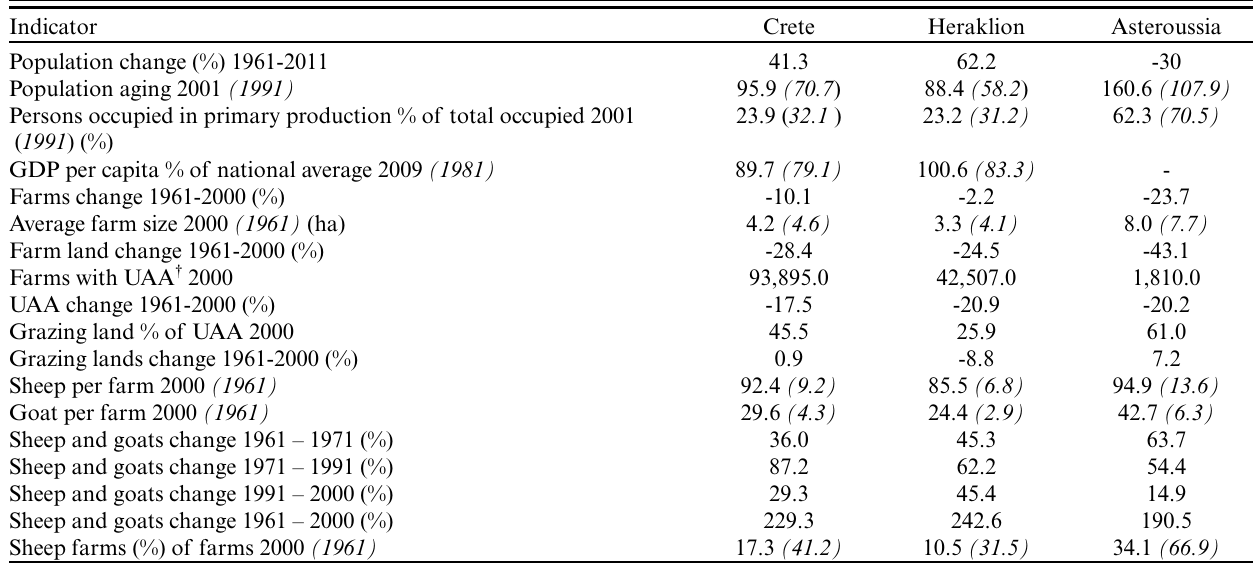
Table 1 . Socioeconomic indicators for Crete, Heraklion, and Asterousia Mountains areas, 1961-2011.